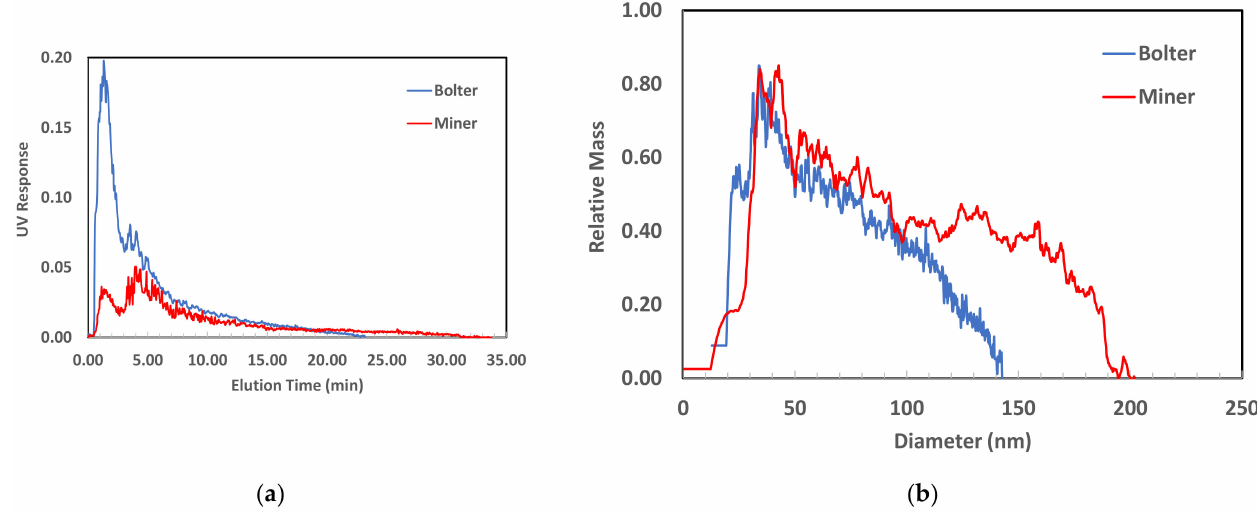
Figure 3. Elution profiles ( a ) and size distributions ( b ) of the RCMD samples obtained from the bolter and the miner sites using